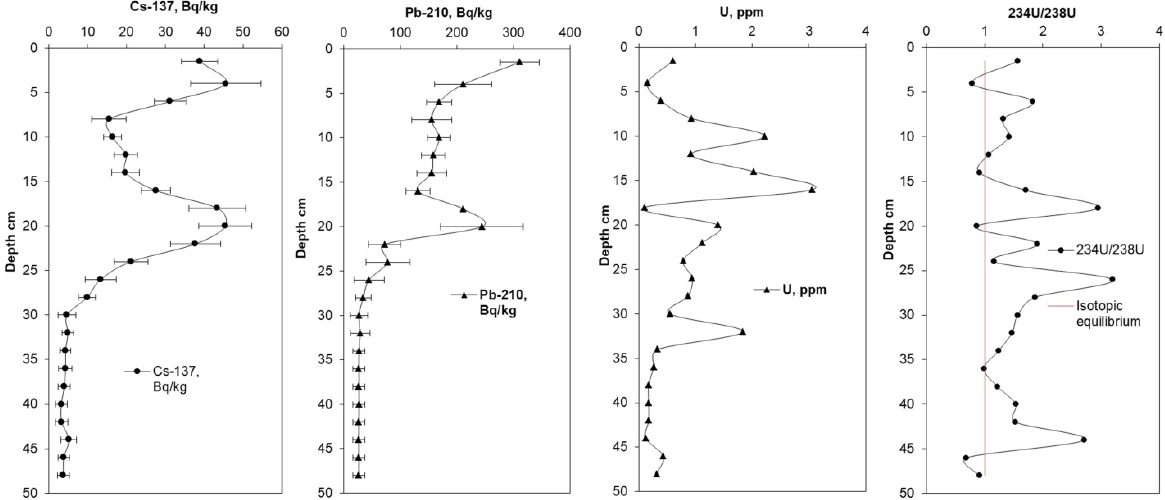
Figure 4. Change in the vertical distribution of radionuclides of the peat profile by depth.